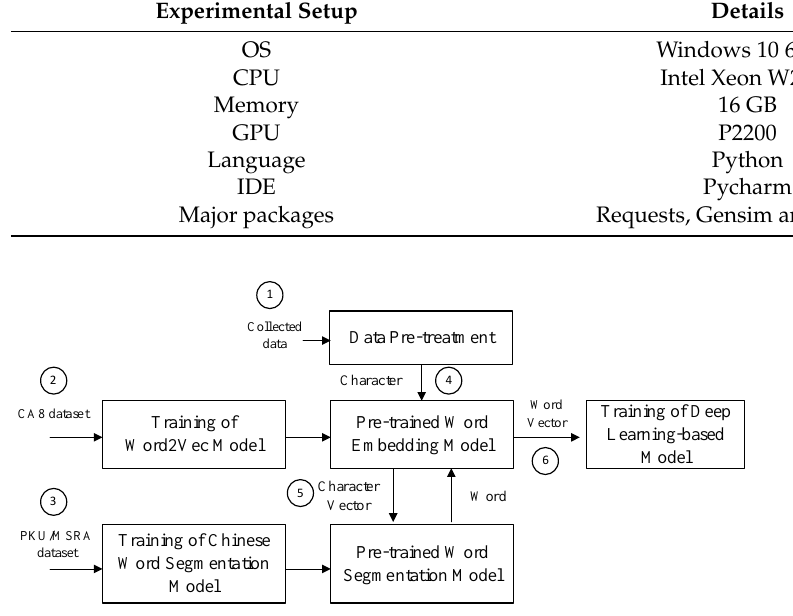
Figure 5. Training procedure of the proposed